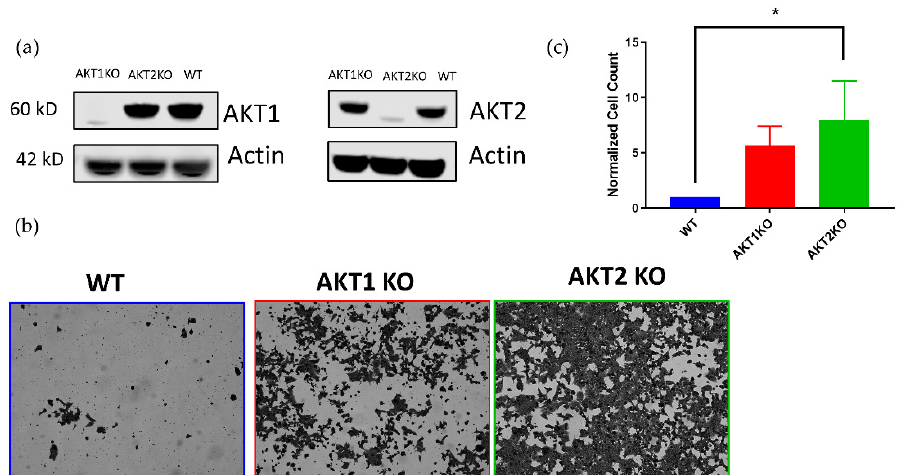
Figure 3. AKT1 knockout (KO)and AKT2 KO 293T cell lines resist LGTV-induced a cytopathic effect